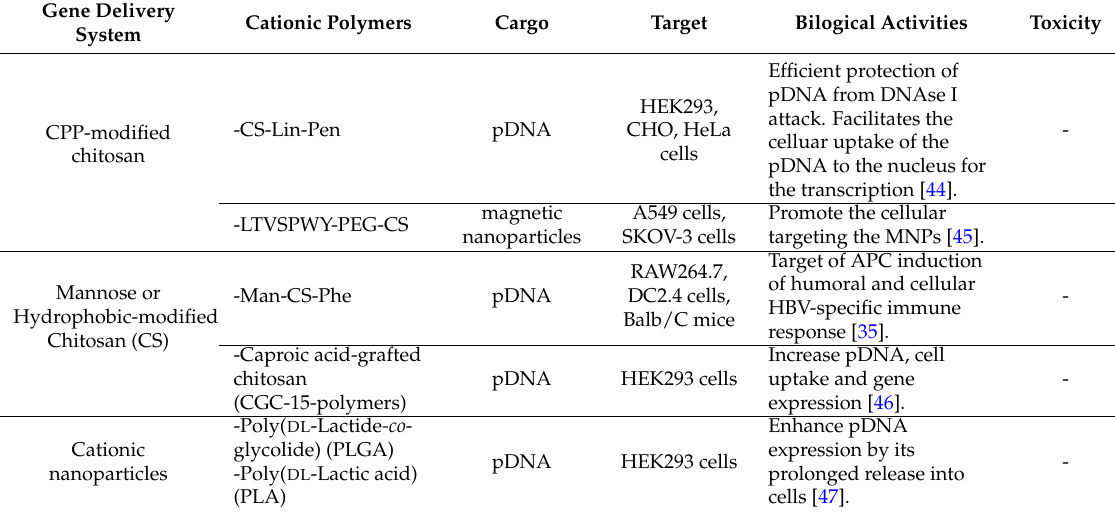
Table 2. Other system for gene